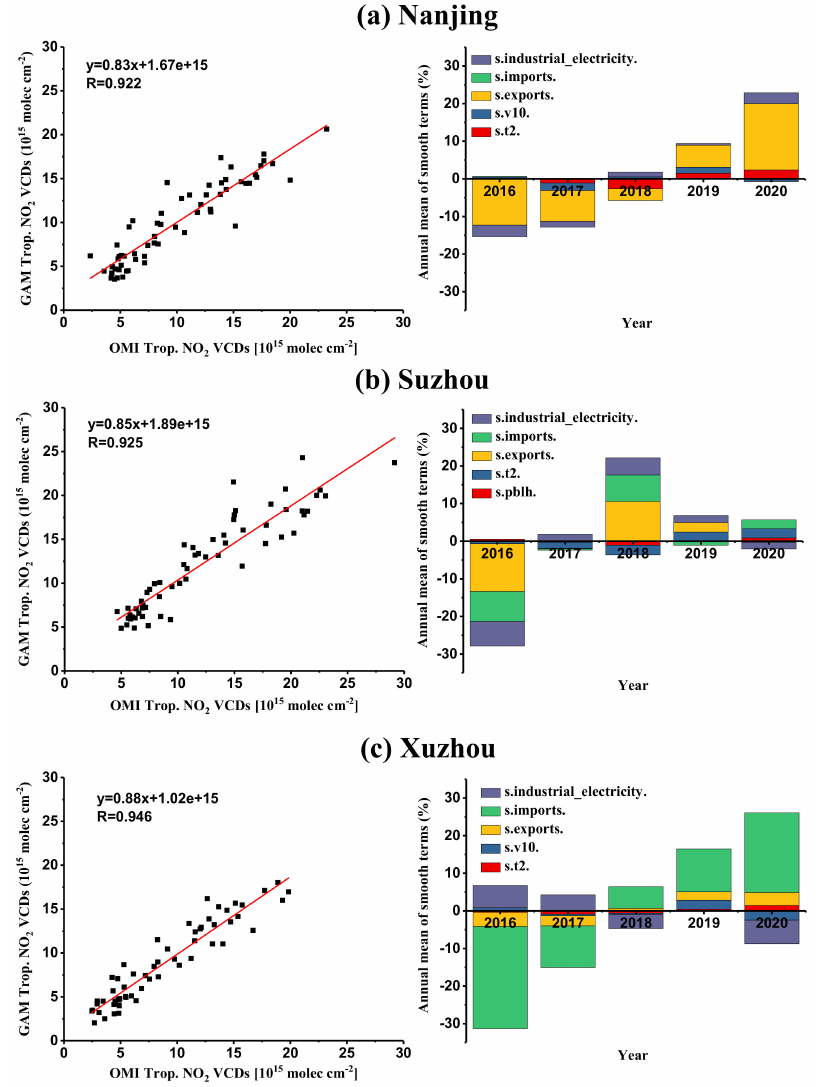
Figure 8. The correlation analysis of tropospheric NO 2 VCDs observed by OMI and the fitted GAM model, and the inter-annual variations of smooth terms explained by each variable. The results of Nanjing ( a ), Suzhou ( b ), and Xuzhou ( c ) are presented,